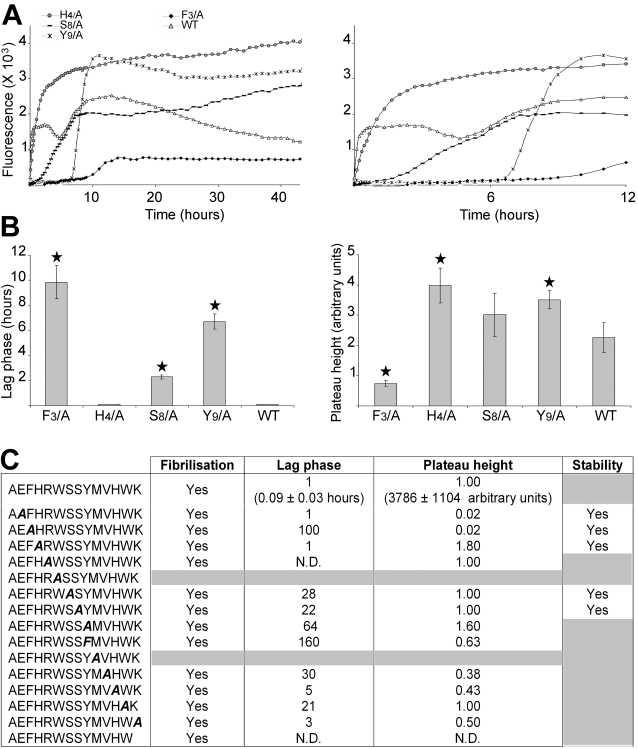
Fibrilization properties of AChE586-599 and AChE586-599 mutants.(A) 100 µM peptide was incubated with 165 µM ThT in PBS. Changes in ThT fluorescence were monitored (A, with the right panel showing scale-up of the left panel to visualize the rapid fibrilization of some peptides) with the lag phase of fibrilization (B, left panel) and plateau height (B, right panel) depicted. A black star signifies p<0.003 (B, left panel) and p<0.03 (B, right panel) when compared to the wild type peptide (WT). The peptides shown are representatives of the different fibrilization properties observed. (C) Fibrilization properties for AChE586-599 and all AChE586-599 mutants (100 µM). The properties are divided into 4 categories: ability to fibrilize, duration of lag phase, height of plateau and stability of the amyloid products (indicated by stability or decay of the ThT fluorescence after plateau). The mutation within AChE586-599 is indicated in bold and italics. The peptides that do not fibrilize and/or the peptides which amyloid products are not stable are indicated by grey boxes. The lag phase and plateau height for the mutant peptides are shown as fold ratio of AChE586-599 (e.g. ‘1’ represents equal value to AChE586-599 and ‘100’ for the lag phase represents 100 times longer than AChE586-599). ‘N.D.’ means ‘not detectable’.